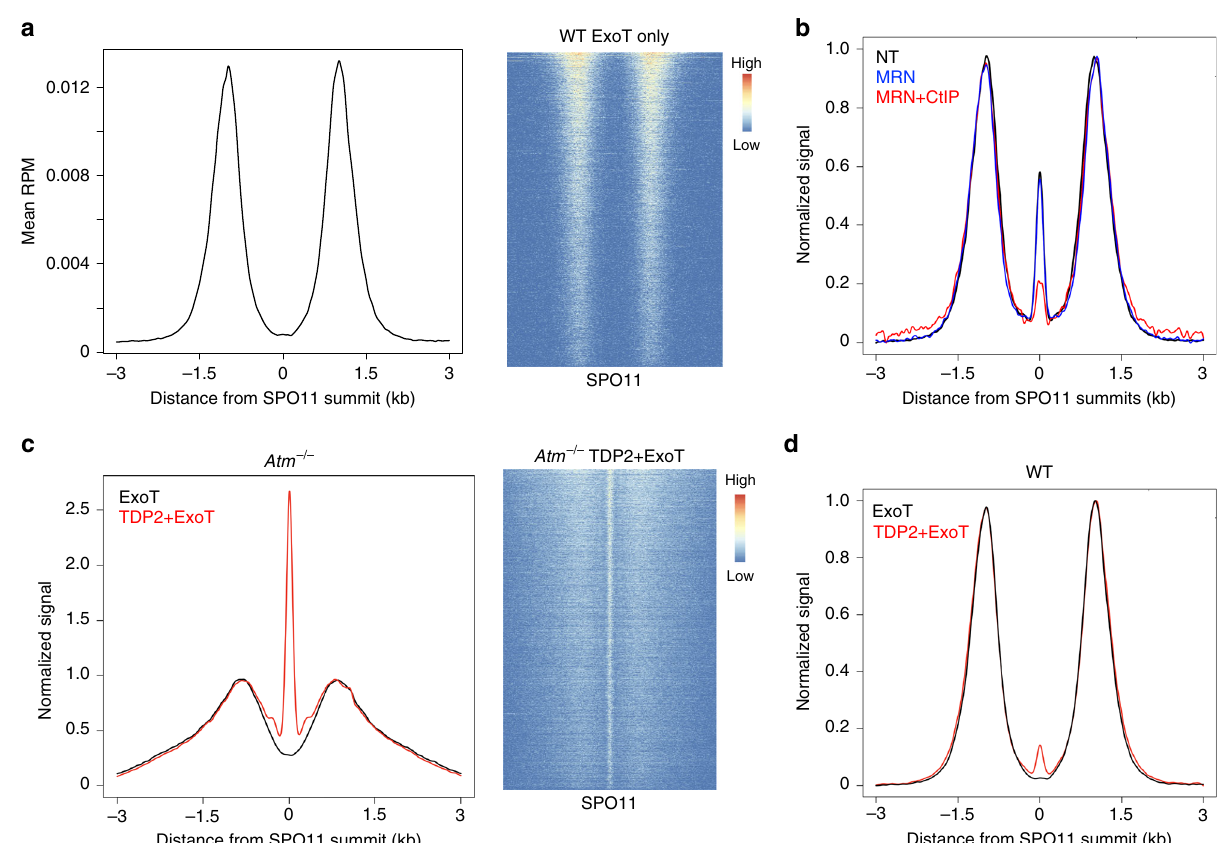
Fig. 6 WT and Atm – / – hotspots contain distinct species of DNA-bound SPO11. a END-seq processing with ExoT blunting alone shows total absence of SPO11 central peak when signal is aggregated around SPO11-oligo summits (left). Heatmap of ExoT only signal ± 3 kb around hotspot centers, ordered by total read count of END-seq (right). b Pretreatment with puri fi ed human MRN + CtIP reduces ExoVII + ExoT central peak detection (red) over no pretreatment (NT, black) and depends on the presence of CtIP (blue). Both MRN and MRN + CtIP reactions were carried out in the presence of manganese. One 12 dpp mouse used per condition. c END-seq with ExoT blunting alone also shows no central peak in Atm – / – cells (black line). Pretreatment with puri fi ed human TDP2 before ExoT incubation recovers SPO11 signal, indicating abundance of unresected, bona fi de SPO11 cleavage complexes (red line). Aggregate plot (left, normalized to same resection height) and heatmap (right) ± 3 kb around SPO11-oligo summits. d END-seq aggregate plot of WT ExoT blunting with (red line) and without (black line) TDP2 pretreatment shows only minor recovery of central peak